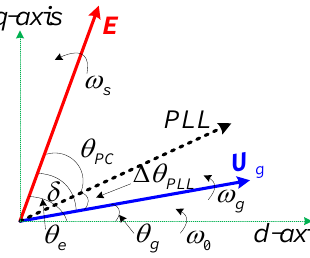
Figure 4. Defined inner potential of WTs.